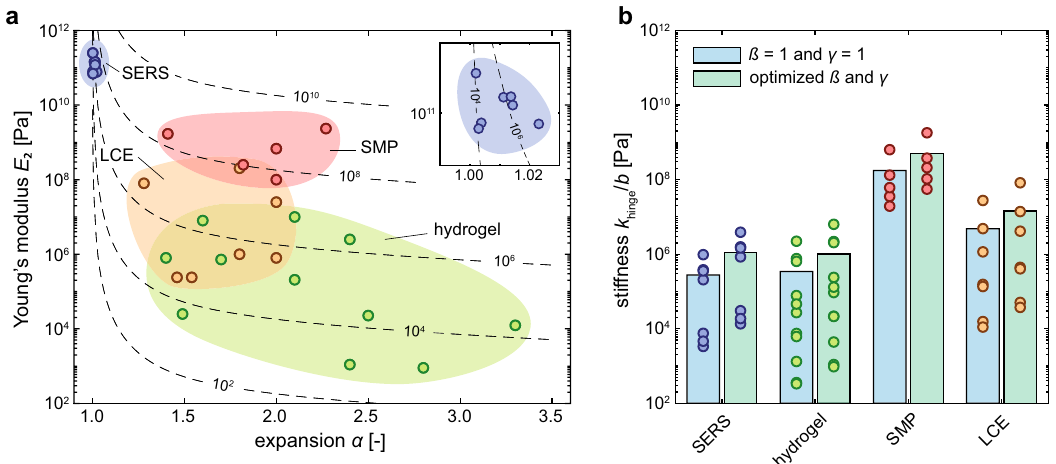
Fig. 6 Stiffness for different active materials. a The elastic moduli and expansion values reported in the literature for the common types of stimuli- responsive materials. The black dashed lines indicate the constant values of k hinge / b . b The hinge stiffness of non-optimized and optimized bilayer con fi gurations for the different types of stimuli-responsive